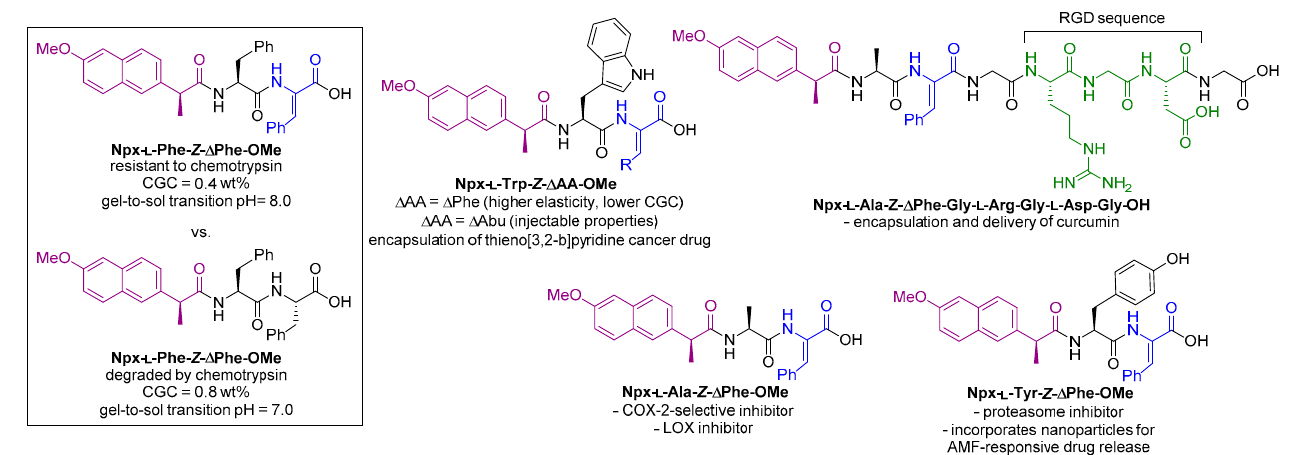
Figure 6. Summary of naproxen-capped peptides capable of forming hydrogels.